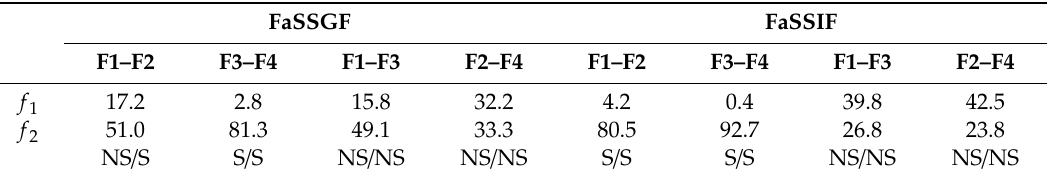
Table 6. Values of ƒ 1 and ƒ 2 obtained in the comparison of the 4 formulations of tablets (F1, F2, F3, F4) in both pH assayed. S: similar; NS: non-similar.